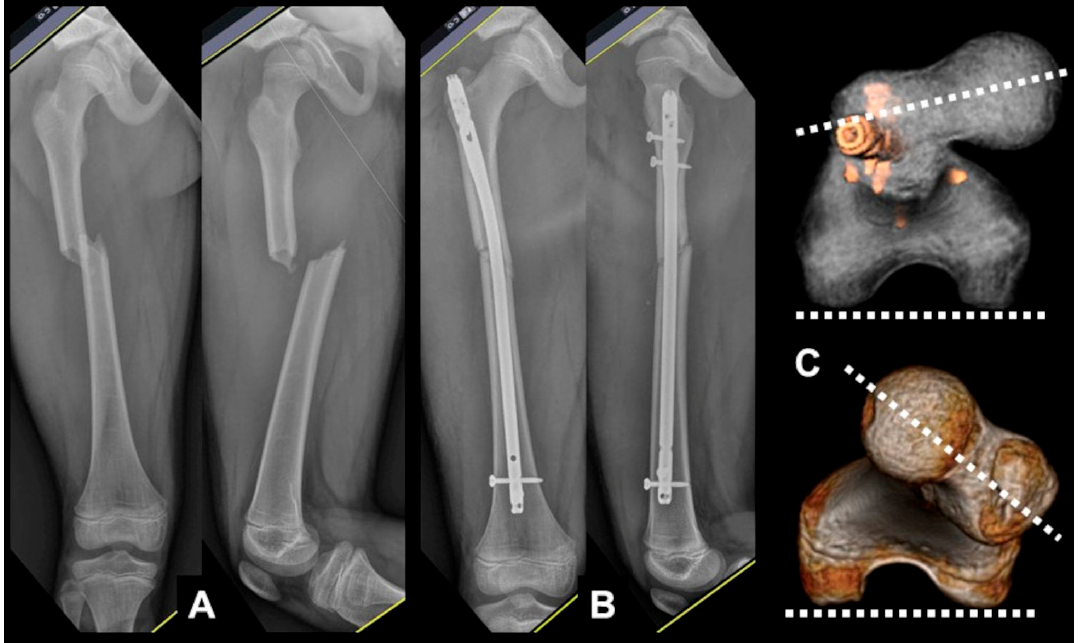
Figure 4. ( A ) An 11-year-old male patient diagnosed with a femoral-shaft fracture; ( B ) IM nailing was carried out; ( C ) postoperative CT scan showing the decreased angle of anteversion compared with the noninjured side.